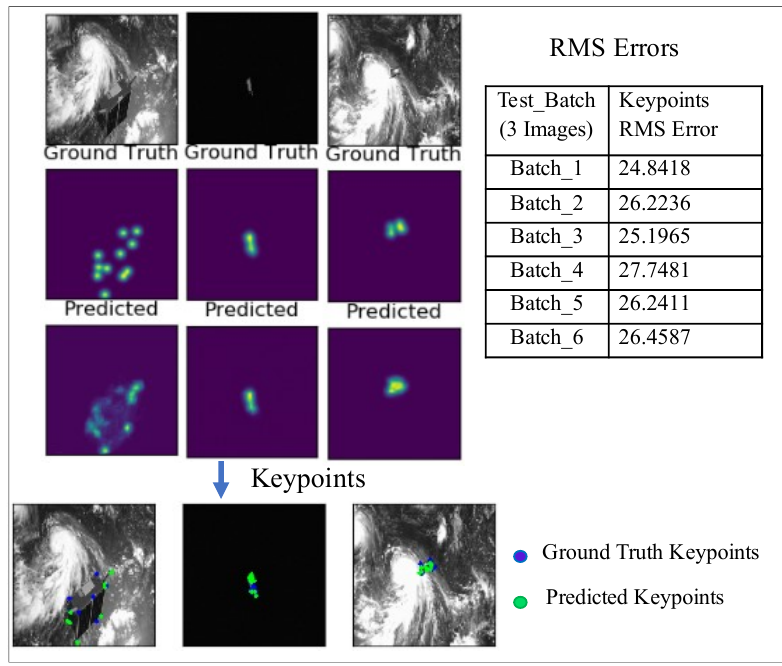
Figure 7. U-Net Model Keypoint Detection Performance on Full